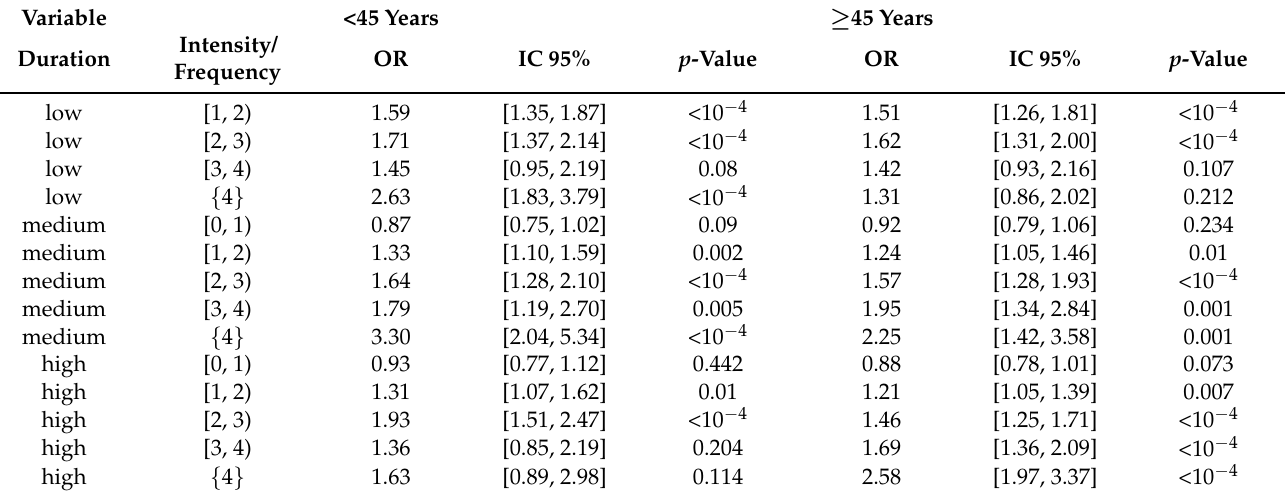
Table 6. Results of adjusted logistic regression of severe knee pain with lifting, for <45 years old and 45 or more participants.